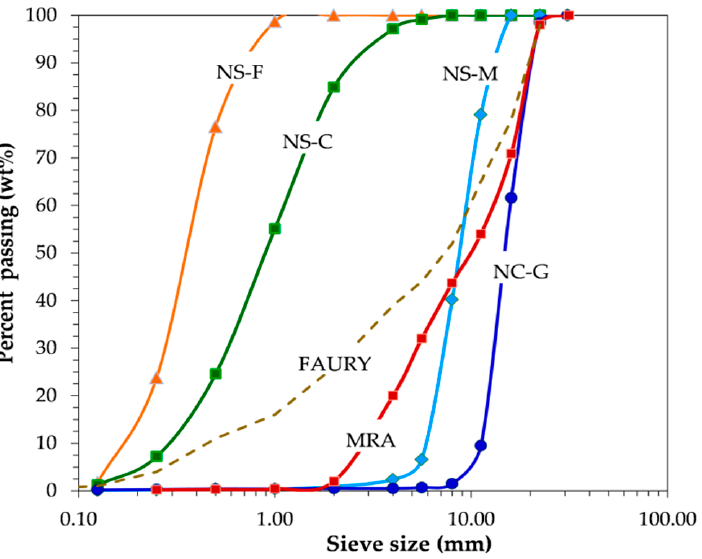
Figure 2. Aggregate particle size distribution and theoretical Faury curve for a maximum aggregate size of 22 mm and 300 kg/cm 3 cement.